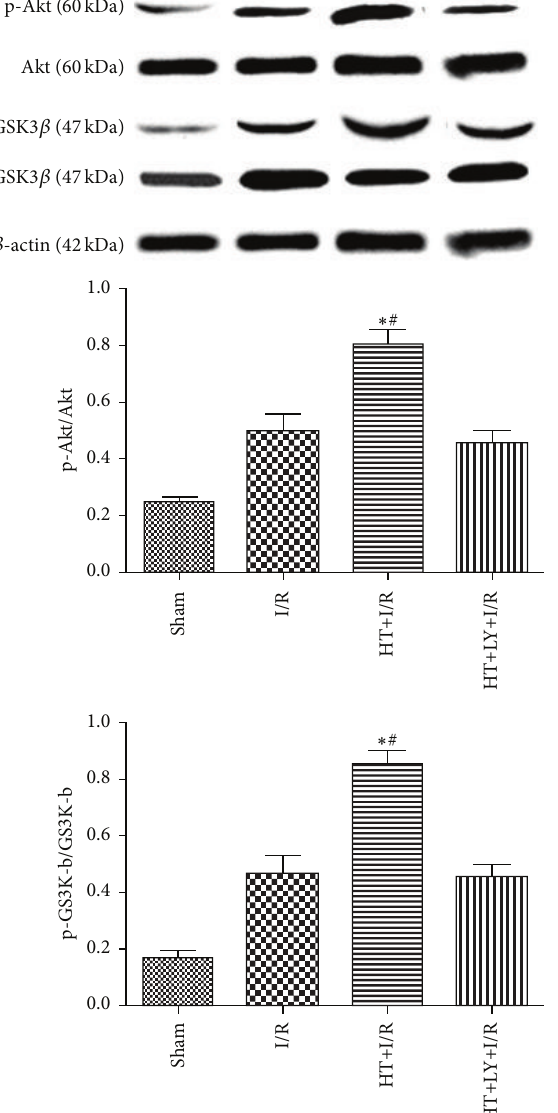
Figure 7: HT increased the levels of phosphorylated Akt and phosphorylated GSK-3 𝛽 in the myocardium ( 𝑛 = 4 for each group). Phosphoinositide 3-kinase inhibition attenuates HT-induced increases in phospho-Akt and phospho-GSK3 𝛽 . The levels of phospho-Akt and phospho-GSK-3 𝛽 were examined by western blot analysis with specific antibodies. ∗ 𝑃 < 0.05 versus I/R group. # 𝑃 < 0.05 versus HT+LY+I/R group.